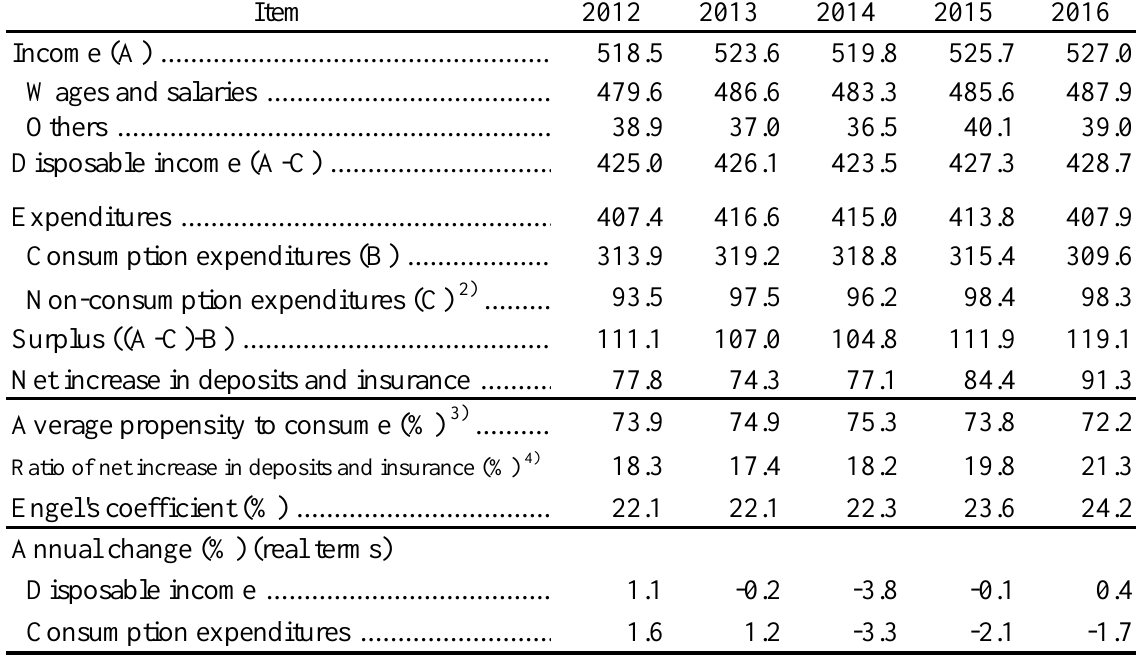
Average Monthly Income and Expenditures (Workers' households 1)